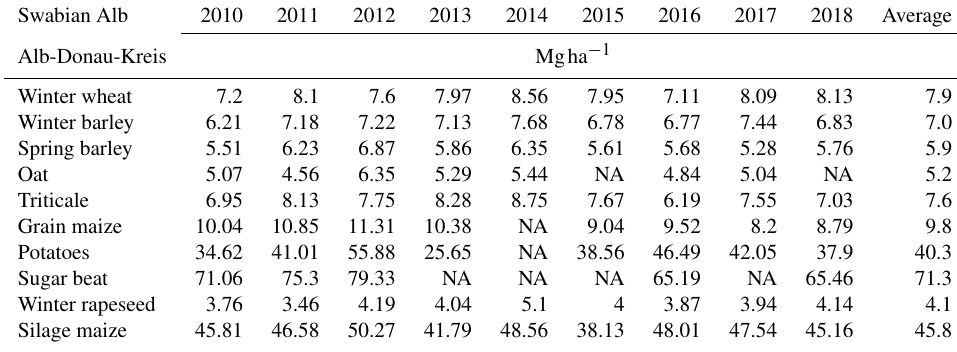
Table B2. Average yields of the Swabian Alb district Alb-Donau for the years 2010–2018. Values that are not available are indicated by